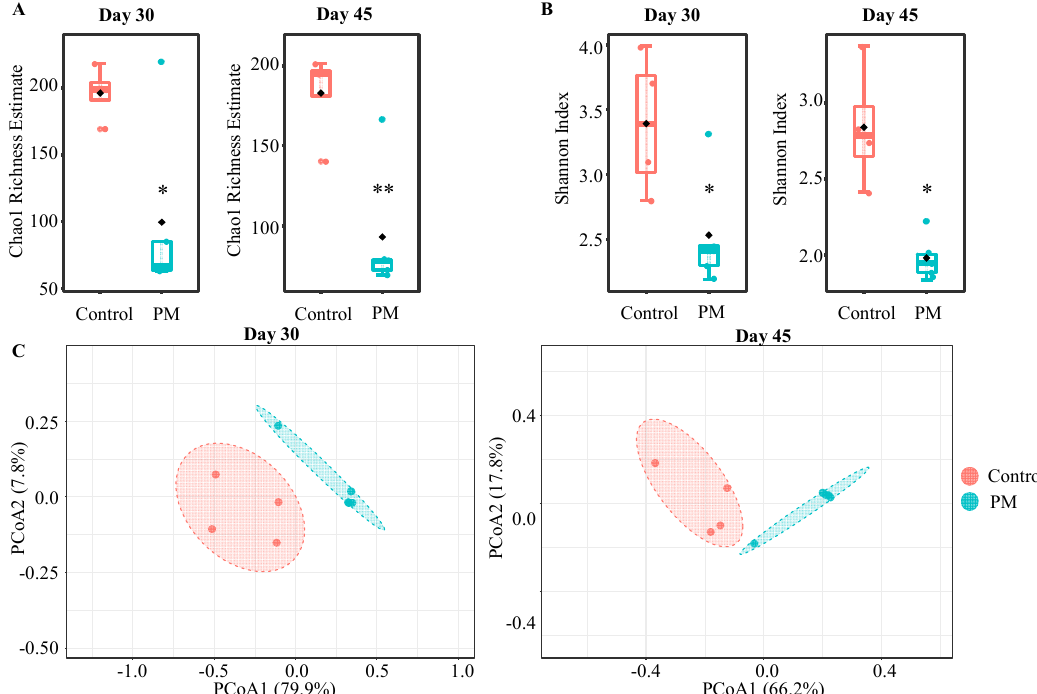
Figure 1. α and β diversity of the fecal microbiota in control and PM-treated mice. α and β diversity analyses were performed using 16S rRNA gene sequencing data of fecal samples from control ( n = 4) and PM-treated ( n = 5) mice collected before (day 0) and at various time-points (days 15, 30 and 45) during the treatment. Chao1 estimates and Shannon indices were employed to evaluate richness and diversity within each sample, respectively, as shown in Supplemental Figure S2. Differences in richness ( A ) and diversity ( B ) indices between treatments at day 30 and 45 are shown here. Statistical significance was assessed using t -tests. * p < 0.05 and ** p < 0.01 ( C ) Principal coordinate analysis (PCoA), by employing Bray–Curtis dissimilarity approach, examining the community structure differences between samples of control and PM treatment groups collected on days 30 and 45.